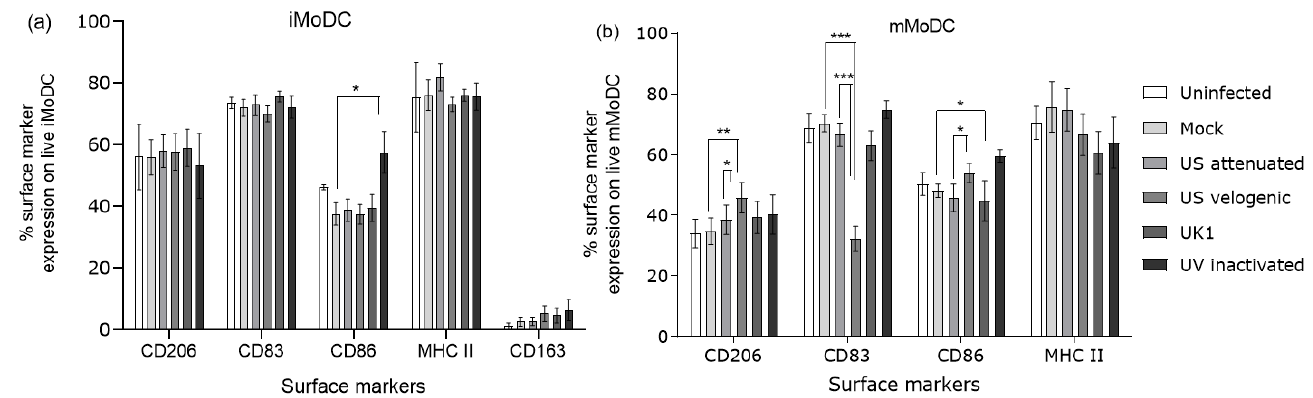
Figure 6. Phenotype of EAV infected live MoDC. Immature MoDC (iMoDC) and mature MoDC (mMoDC) were inoculated at MOI of 5 with different strains of live or UV inactivated EAV. Controls were uninfected (media only) and mock infected cells. Cultures were incubated at 37 °C in 5% CO 2 for 16 h after which cells were harvested and stained to assess phenotype. Cells were stained with the live/dead fixable vioblue dead cell kit, followed by staining with anti-CD206-PE, anti-CD83- PECy5, anti-CD86-PECy5 and anti-MHC II-APC mAbs. Stained cells of the different treatments were assessed by comparing the same number of events (10,000) in the live cell target gate. ( a ) There were no biologically significant changes in the phenotype of EAV infected iMoDC. ( b ) The Velogenic strain significantly increased the expression of CD206 but decreased the expression of CD83 on mMoDC, thus rendering a more immature phenotype. There were no significant changes in the expression of CD86 and MHC II. Results were represented as the % surface marker expression of nine independent repeats ± SEM. A 2-way ANOVA with Bonferroni post-test was used to compare replicate means. *, ** and *** indicate significant differences between sample means where p < 0.05, p < 0.01 and p < 0.001, respectively.